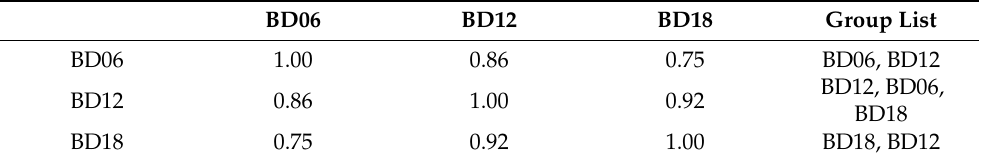
Table 1. Correlation values for pairs among BD06, BD12, and BD18 and the corresponding raw groups for highly correlated variables (correlation higher than the threshold,